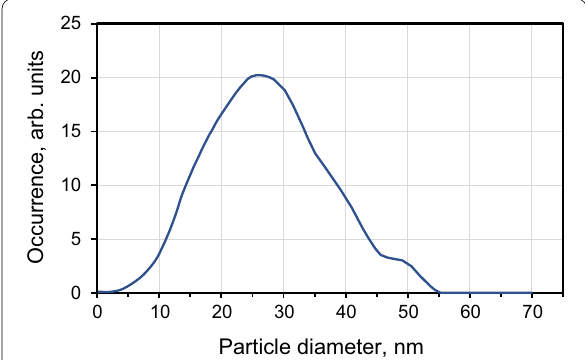
Fig. 2 The size distribution of the DP 0–0.05 polycrystalline diamond fraction with a mean size ~ 27 nm measured by a differential centrifugal sedimentation apparatus (CPS disc centrifuge, CPS Instruments Inc., USA)